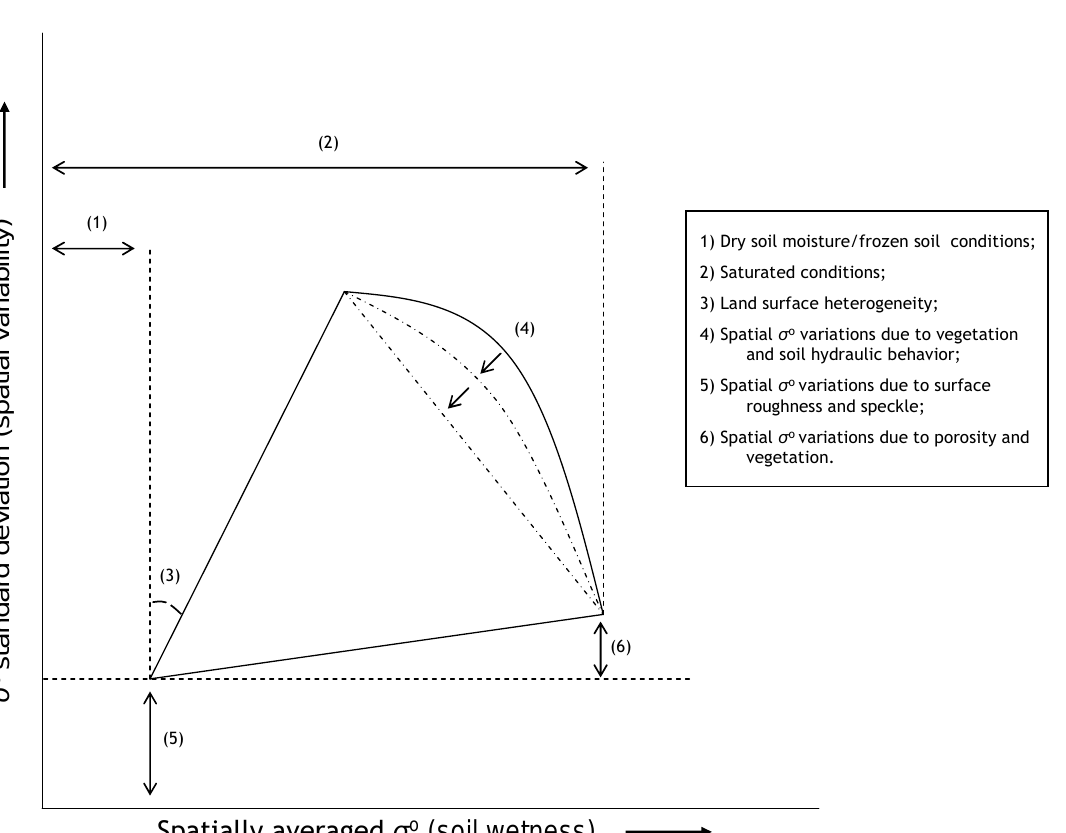
Figure 4. Schematization of the relationship between the mean σ o and the standard deviation, and its coherence with specific land surface conditions and land surface characteristics (e.g. soil texture and